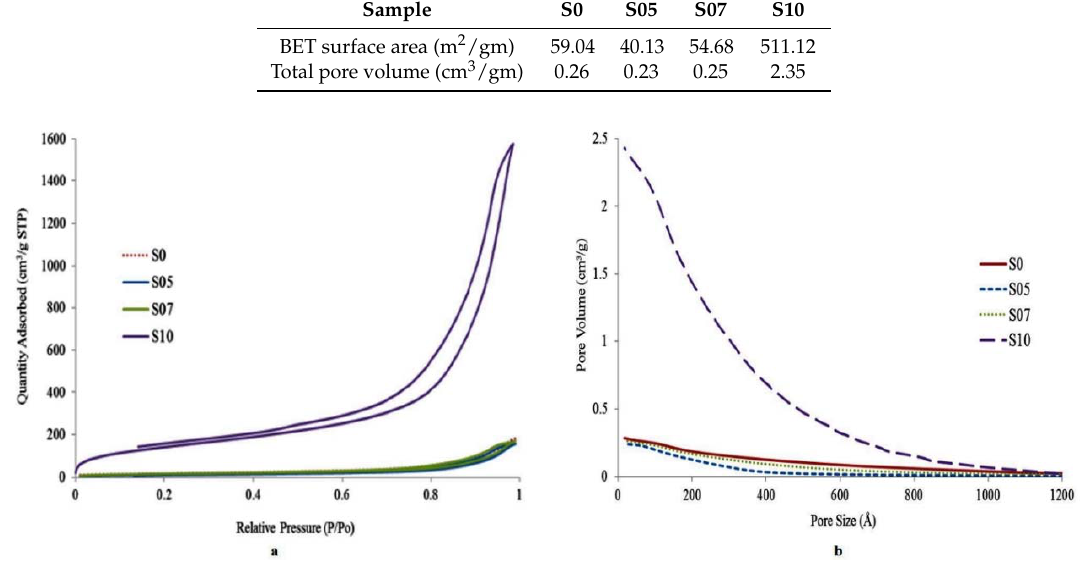
Figure 3. ( a ) N 2 adsorption ‐ desorption curves, ( b ) Distribution micropore size.